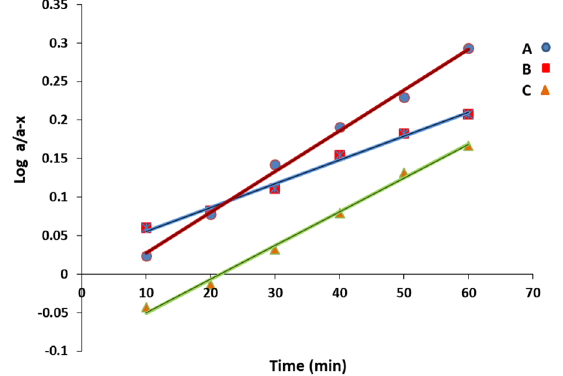
Figure 8: Semilogarithmic plot of SOT (260.0 ng/mL) versus different exposure times with: (A) 2 M NaOH, (B) 2 M HCl and (C) 0.5% H room temperature (n=5).